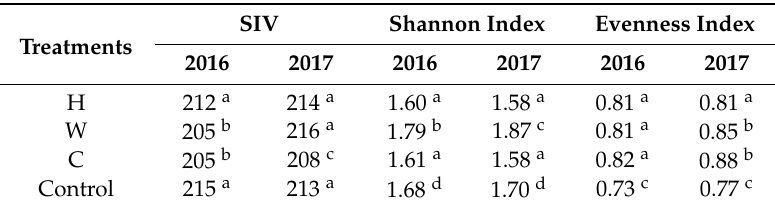
Table 5. Tree species diversity indexes for the studied areas (Kruskal–Wallis test analysis, df 3, 144; p < 0.05; average ± SD).